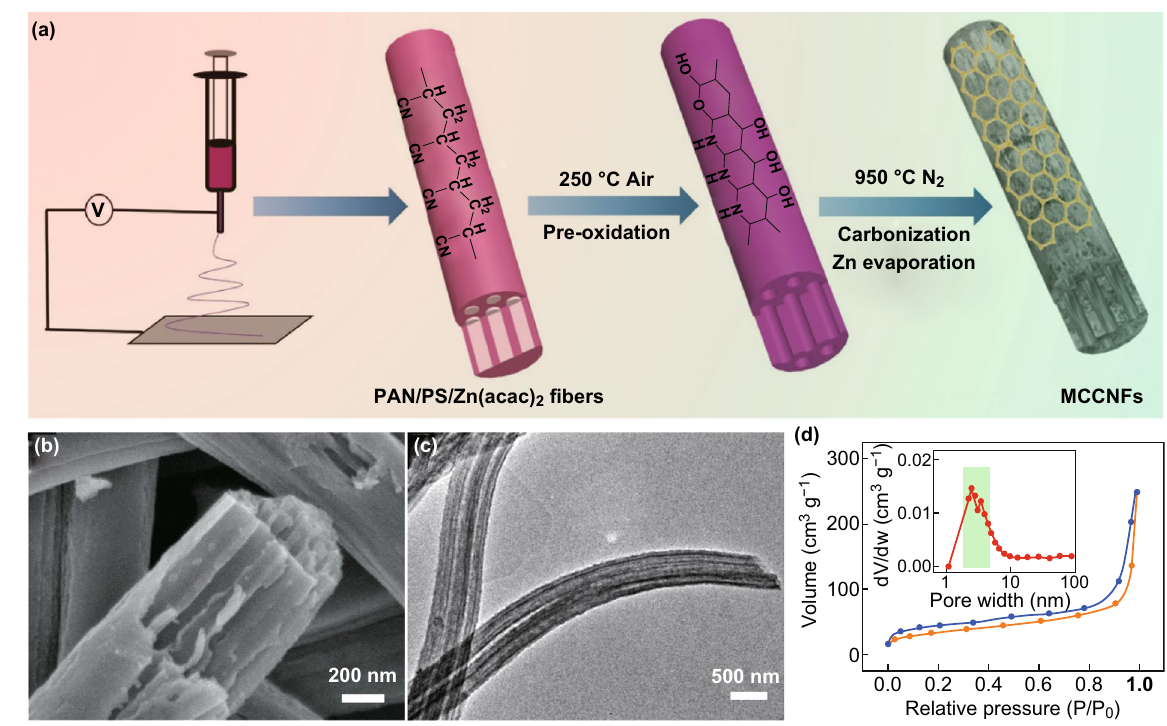
Fig. 1 a Schematic of the formation of interconnected channels in the MCCNFs. b, c SEM and TEM images of the MCCNFs. d N 2 adsorption and desorption isotherms of the porous MCCNFs (inset: pore size distribution of the porous